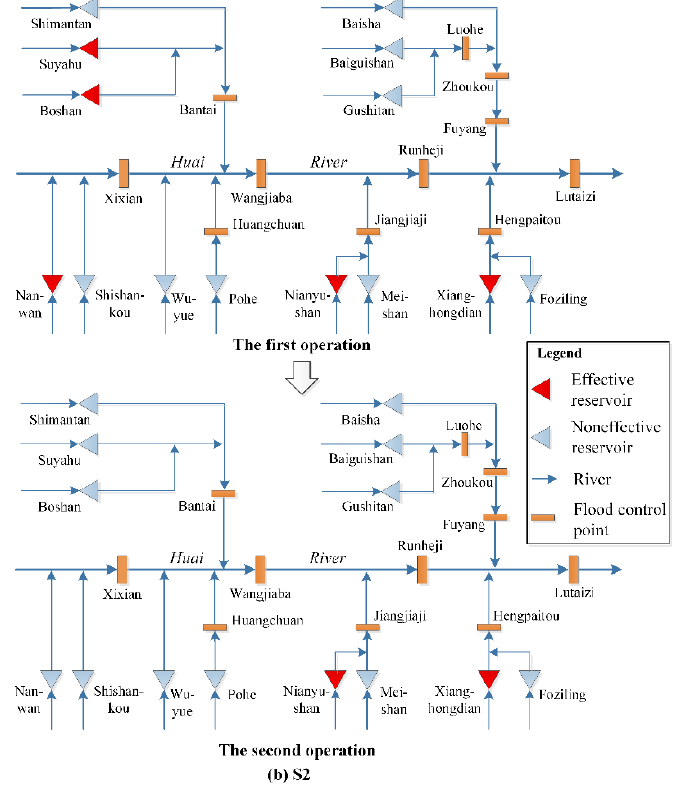
Figure 6. Effective reservoirs of ( a ) S1 and ( b ) S2.